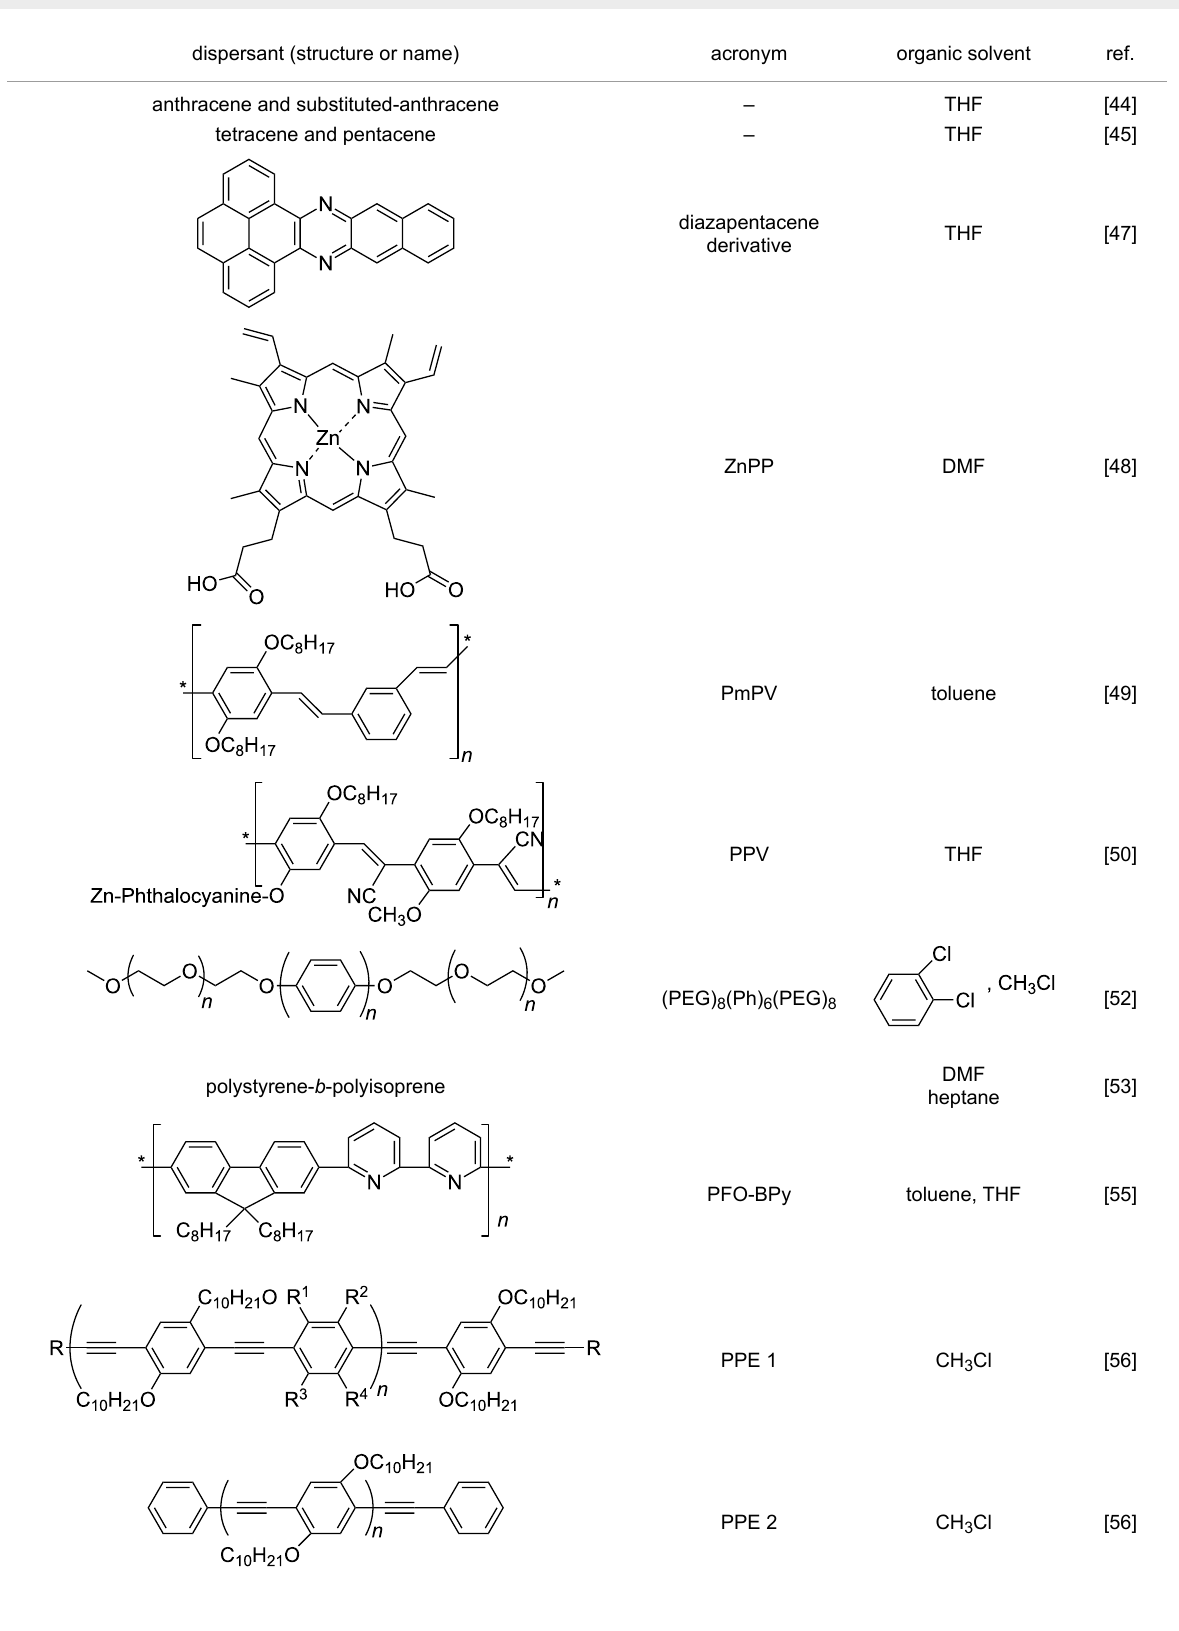
Table 1: Some lipophilic molecules used for the dispersion of CNTs in organic